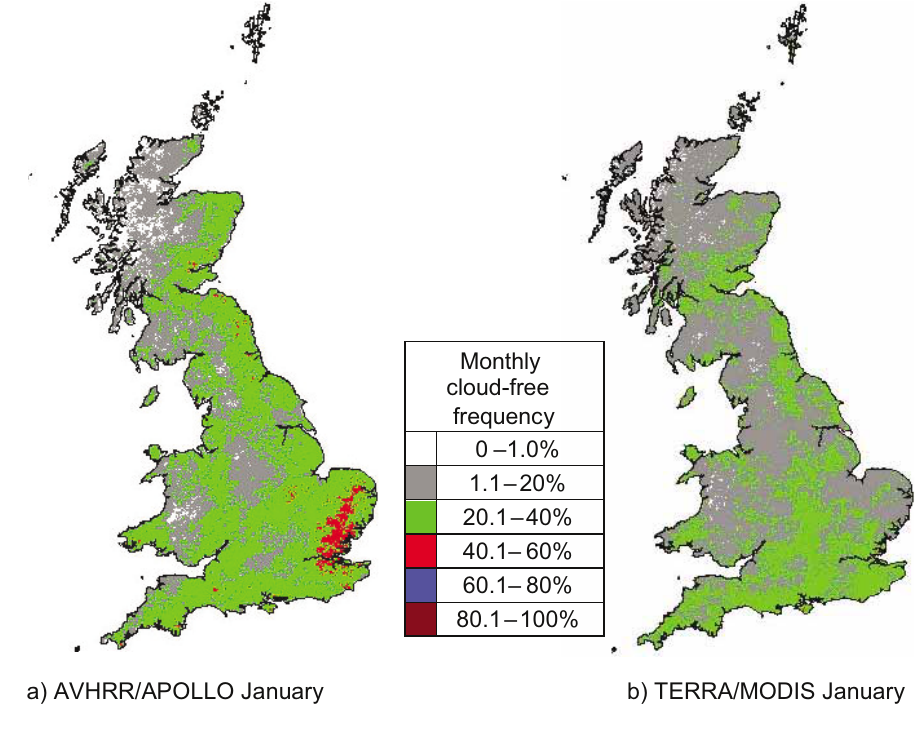
Fig. 1. Classification of monthly cloud-free pixels in the UK